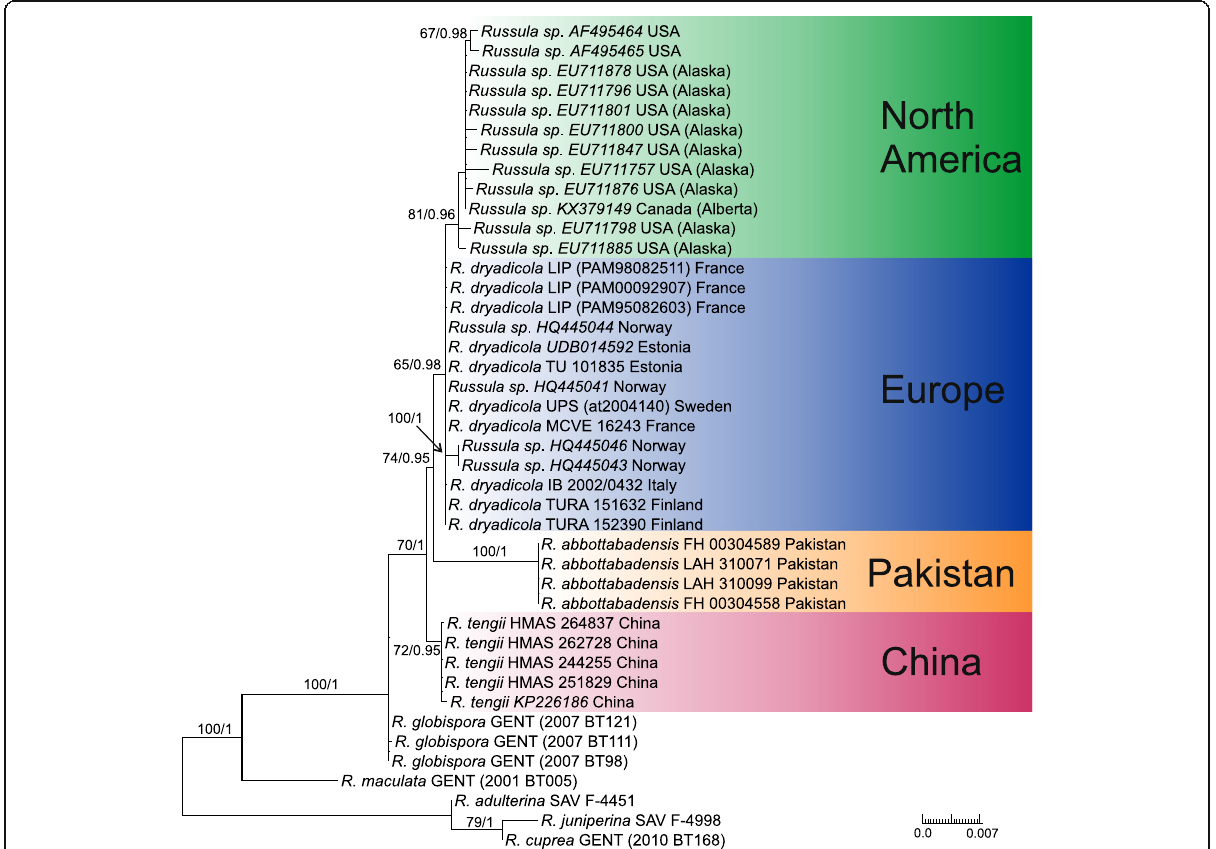
Fig. 1 Phylogram generated by Maximum Likelihood (RAxML) analysis based on combined sequence data of ITS, mtSSU and rpb2 for five species of Russula subsect. Maculatinae and three outgroup sequences. Maximum likelihood bootstrap support values greater than 50% and Bayesian posterior probabilities greater or equal to 0.90 are indicated above or below the nodes. More details about all sequences used in this study are presented in Additional file 1: Table